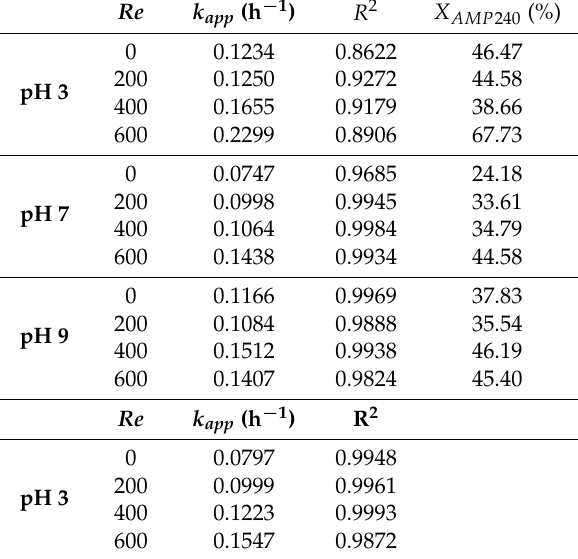
Table 1. Values of the kinetic parameters according to pseudo-first-order kinetics and the coefficient of determination ( R 2 ) for the data fitted for 240 min of reaction time (top of the table) and for data fitted for the first 120 min of reaction time (bottom of the